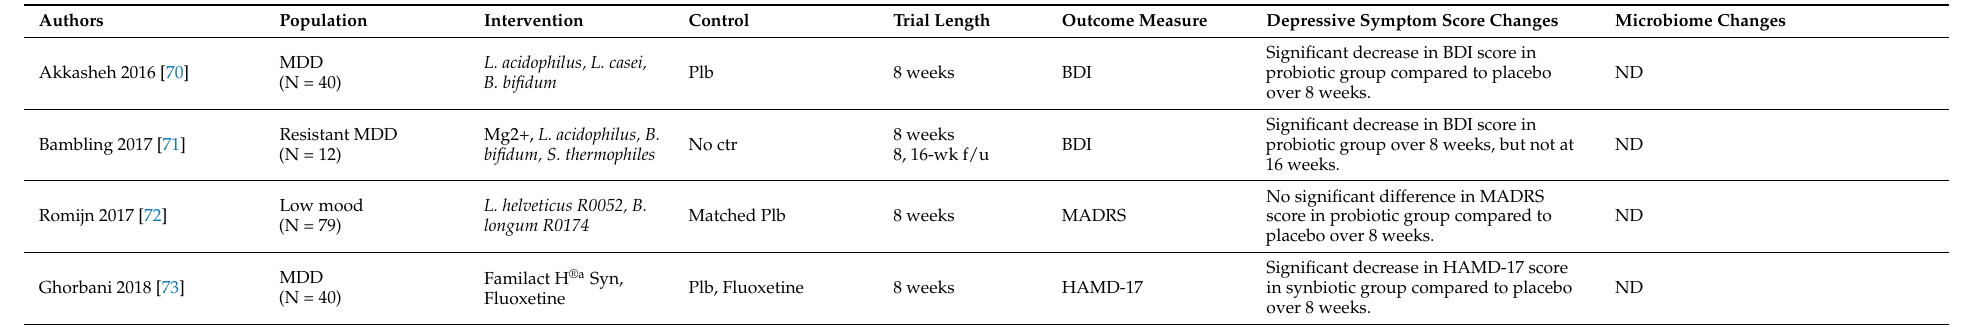
Table 5. Major findings in the clinical trials on prebiotics, probiotics and synbiotics in major depressive disorder included in the systematic